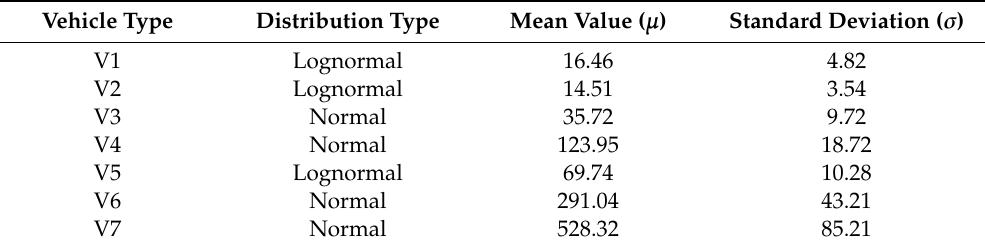
Table 4. Probabilistic properties of GVW for each type of vehicle (kN).